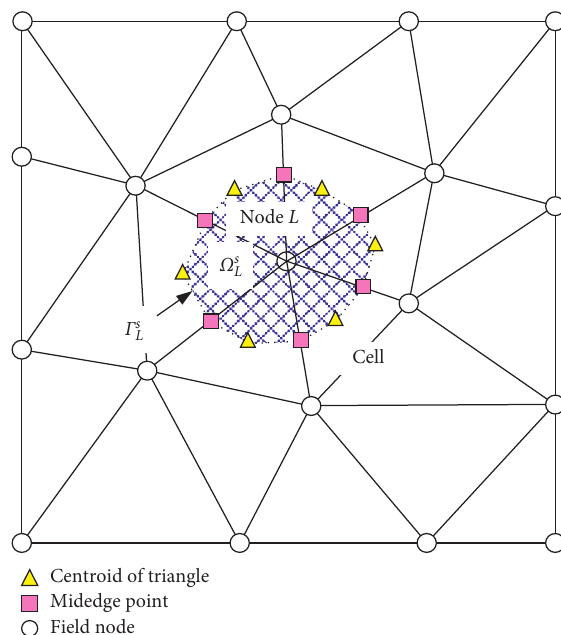
Figure 2: Triangular elements and smoothing cells associated with